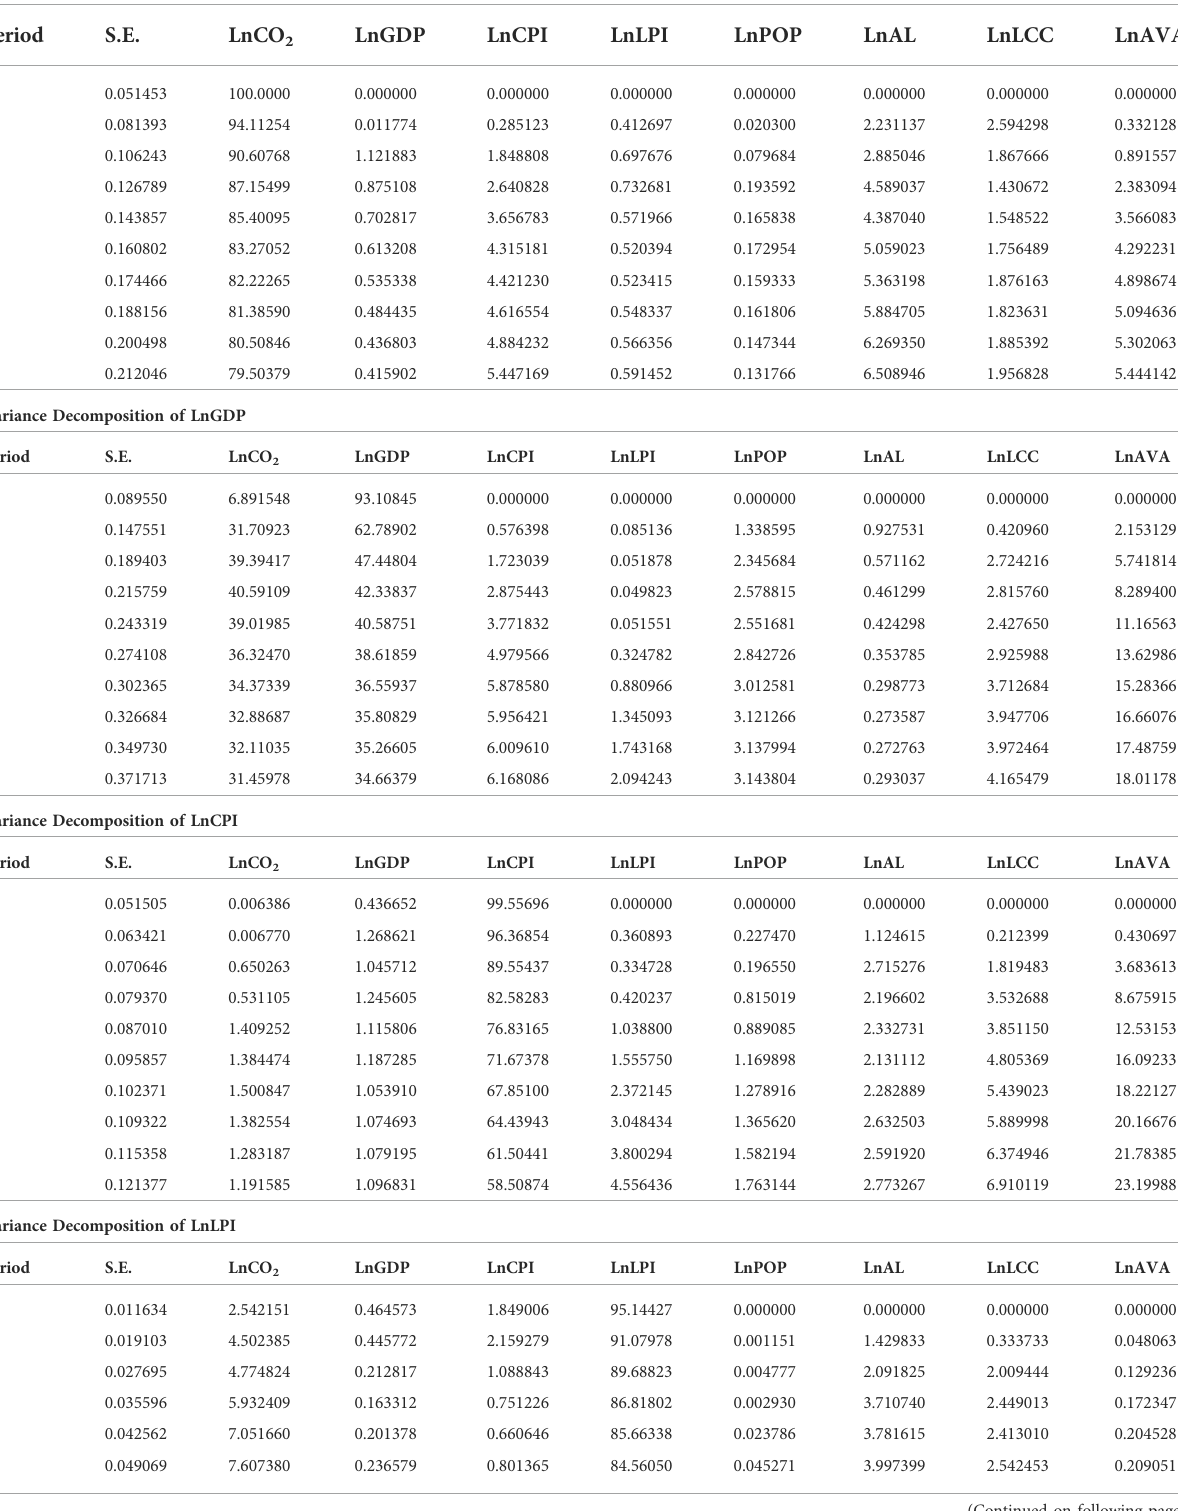
TABLE 11 Variance decomposition cholesky ordering: LnCO 2 LnGDP LnCPI LnLPI LnPOP LnAL LnLCC